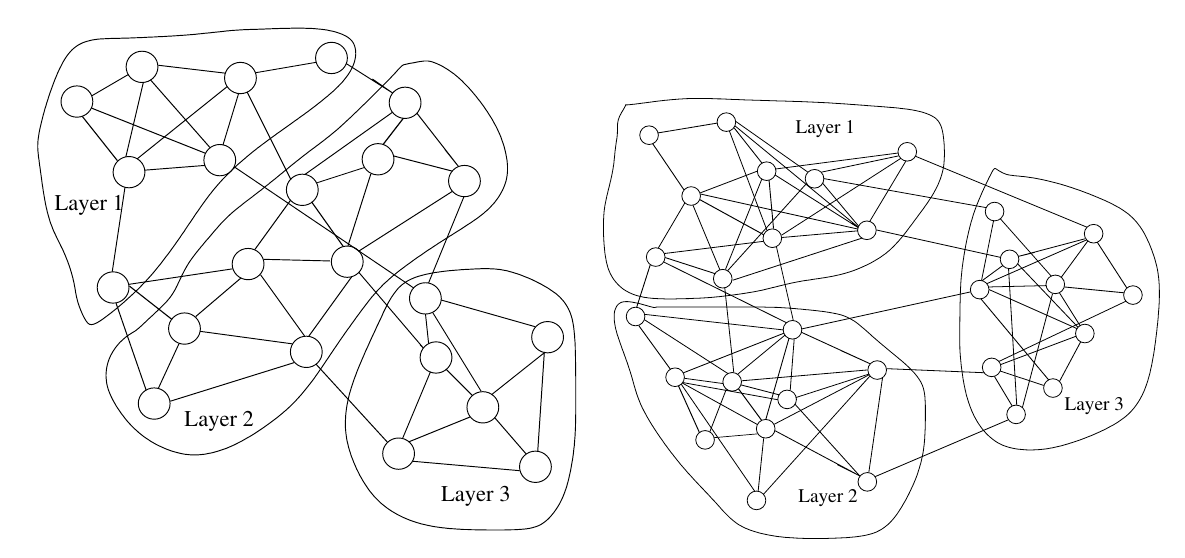
Figure 4. Network topologies with 22 and 30 nodes.